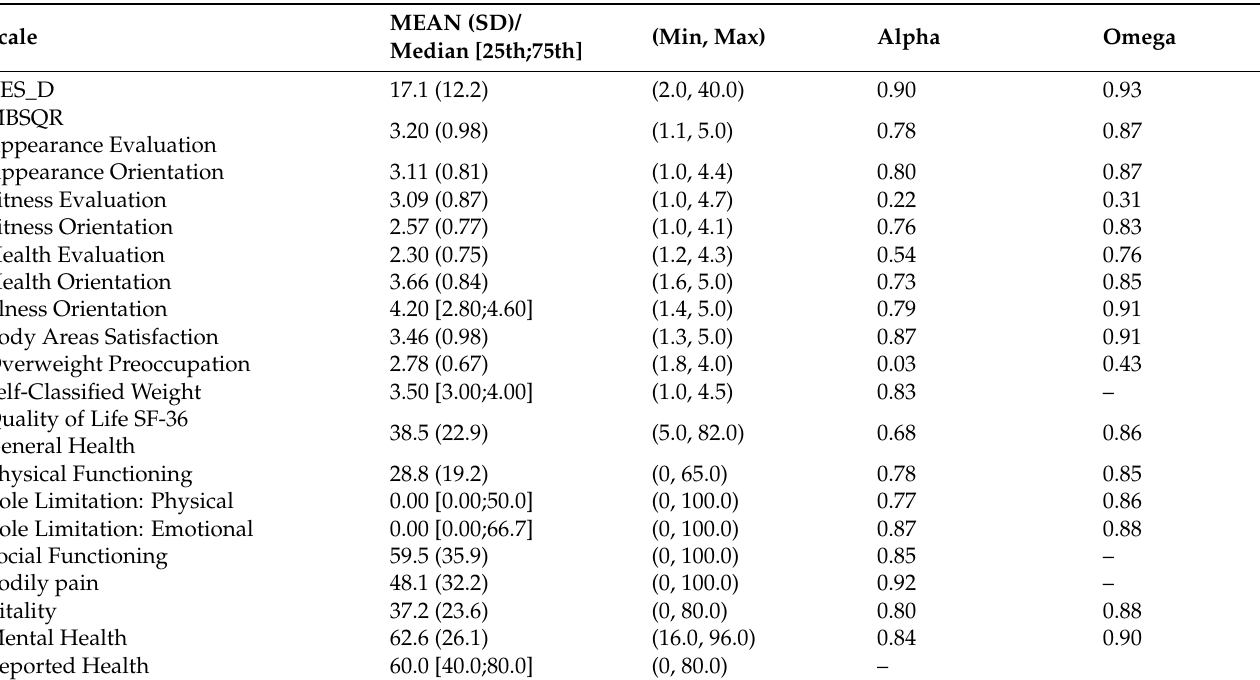
Table 2. All scales distribution, N =